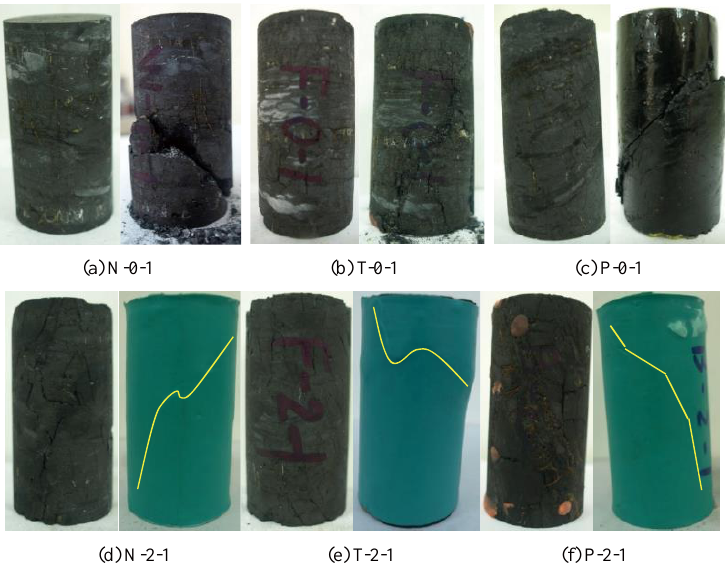
Figure 11. Images of coal samples before and after tests under different mining-induced stress Figure11. Imagesofcoalsamplesbeforeandaftertestsunderdi ff conditions.